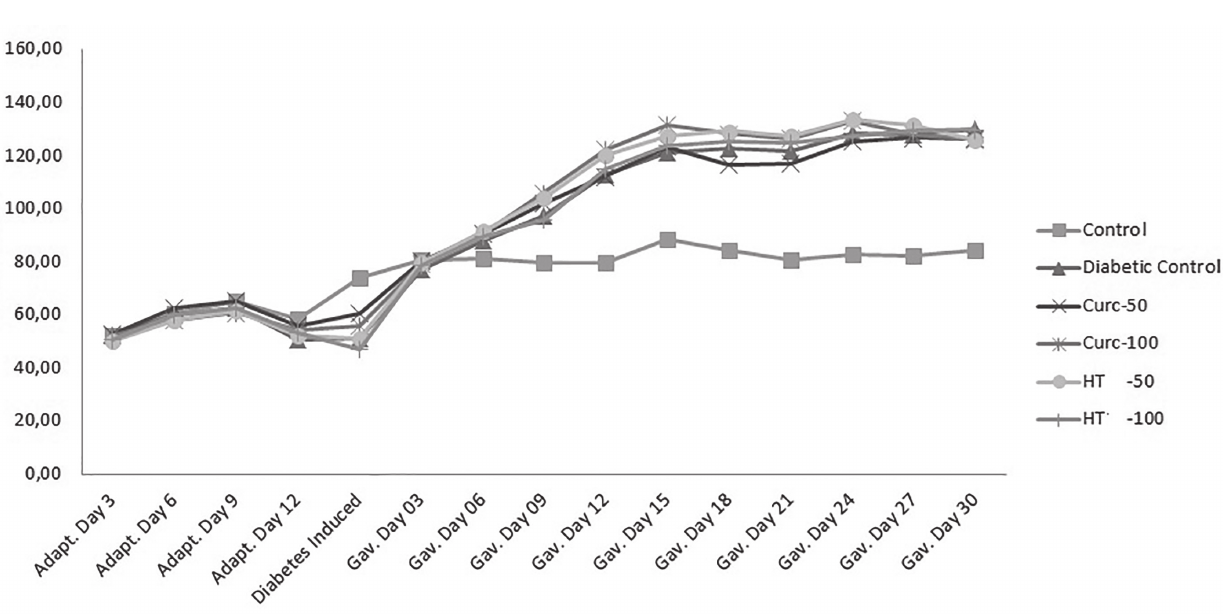
-50 = 2 -100 = group HTNO -100, diabetic, HTNO 2 2 2